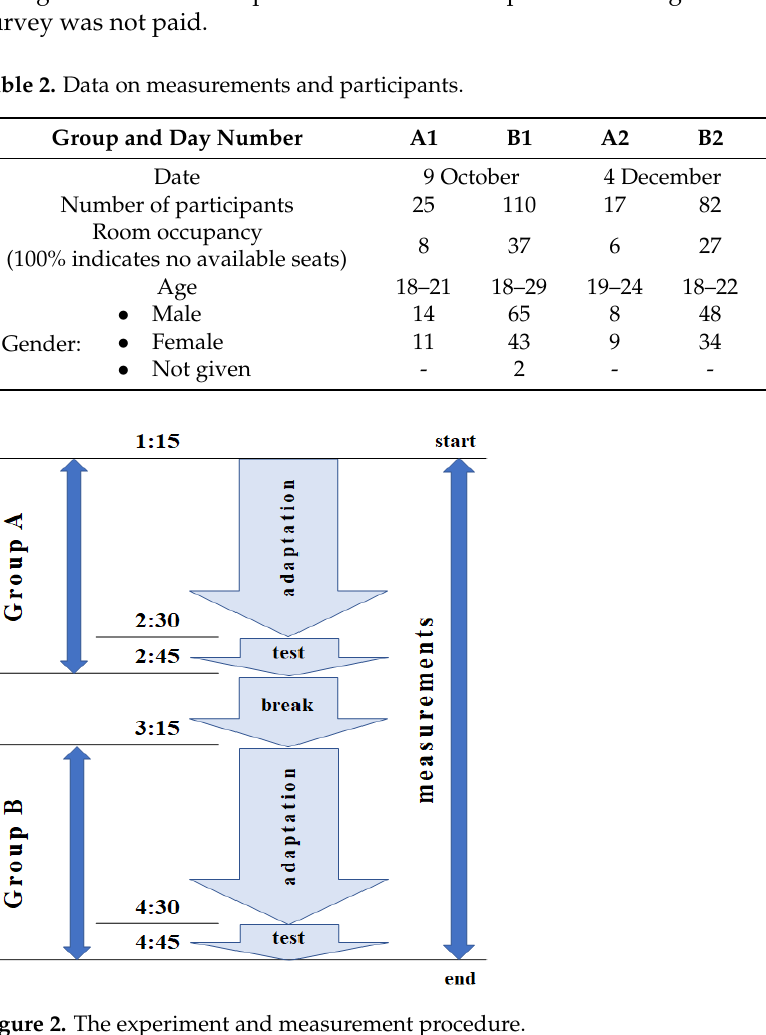
Table 2. Data on measurements and participants.